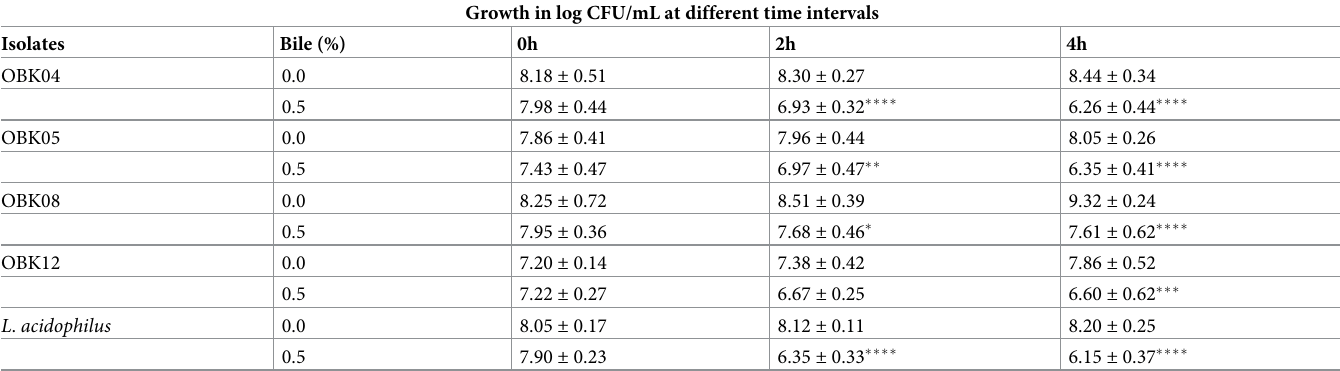
Table 2. Tolerance of Lactic acid bacterial (LAB) isolates to Ox bile. Growth in log CFU/mL at different time